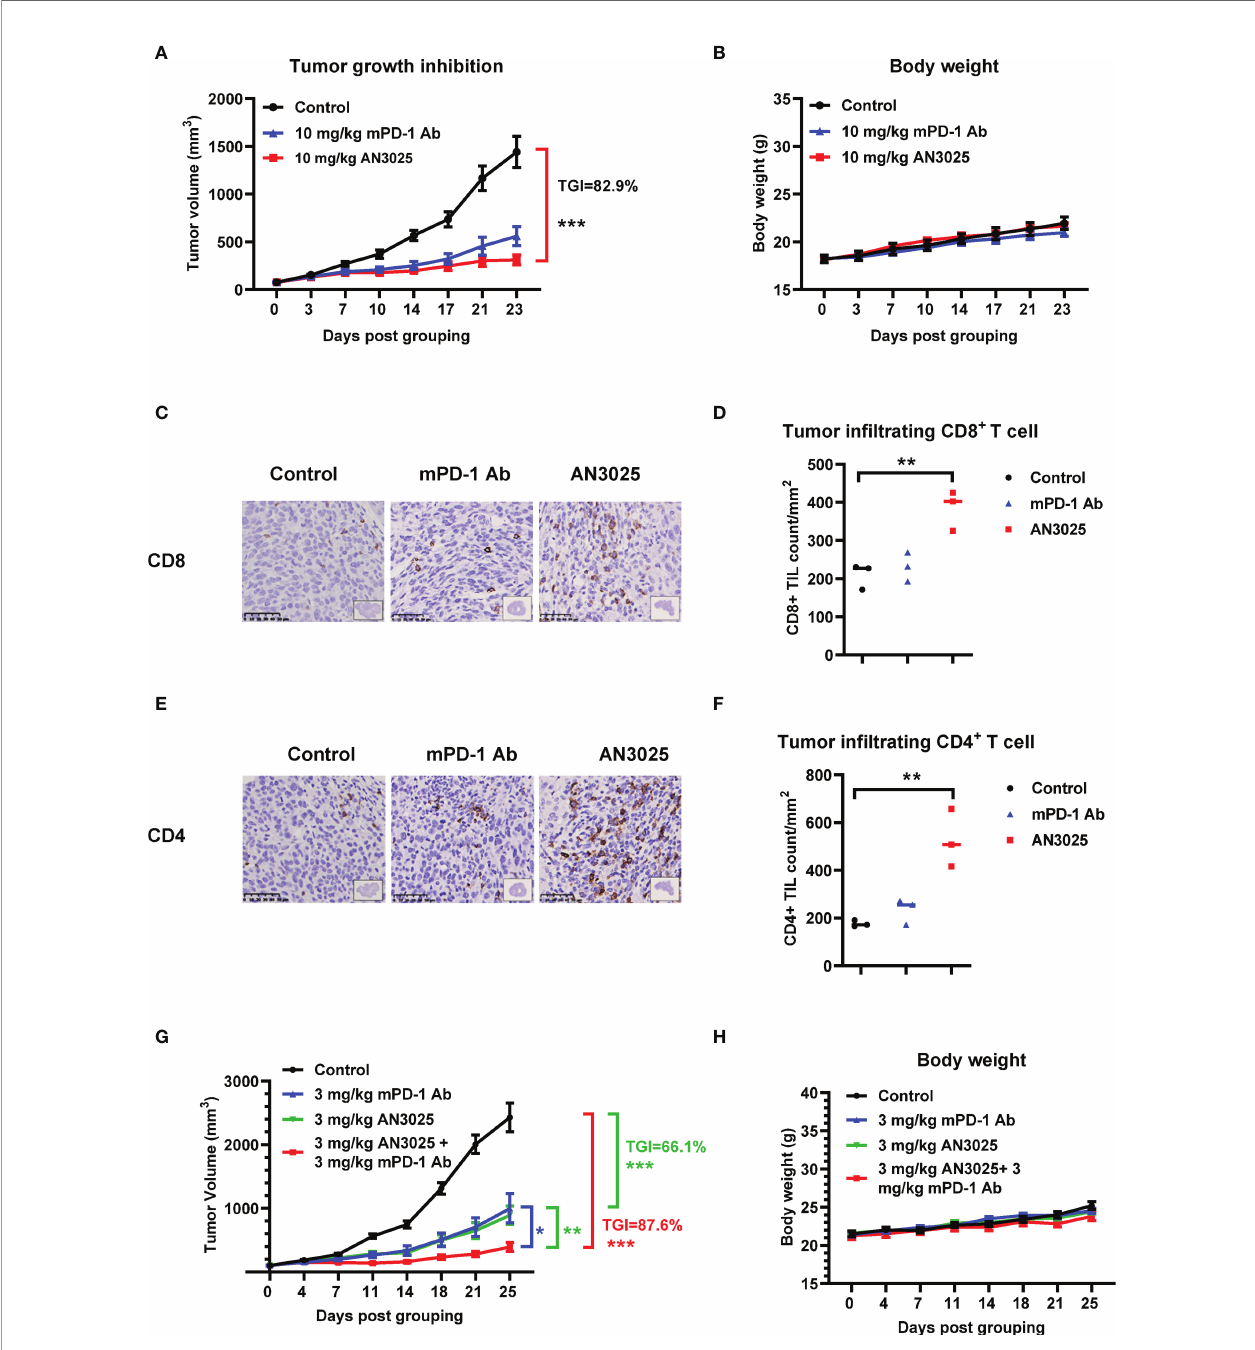
FIGURE 4 | AN3025 enhances anti-tumor ef fi cacy of mouse PD-1 antibody in combination study. (A – H) Murine colon cancer MC38 cells (5E5) were implanted subcutaneously into homozygous TNFR2 humanized mice (female). Mice were grouped when tumor volume reached approximately 100 mm 3 . (A – F) MC38 tumor bearing TNFR2 humanized mice were treated with 10 mg/kg AN3025 or 10mg/kg mouse PD-1 antibody (mPD-1 Ab) every 3 days intraperitoneally for 7 doses in total. (A) Tumor volume measurement during the treatment (n=8 each group). (B) Body weight record during the treatment (n=8 each group). (C) Representative immunohistochemistry images of CD8 staining on MC38 tumors. (D) Quanti fi cations of CD8 + T cells per mm 2 by immunohistochemistry (n=3 each group). (E) Representative immunohistochemistry images of CD4 staining on MC38 tumors. (F) Quanti fi cations of CD4 + T cells per mm 2 by immunohistochemistry (n=3 each group). (G, H) MC38 tumor bearing TNFR2 humanized mice were treated with 3mg/kg AN3025 or 3mg/kg mPD-1 Ab or combination of AN3025 and mPD-1 Ab every 3 days intraperitoneally for 7 doses in total. (G) Tumor volume measurement during the treatment (n=8 each group). (H) Body weight record during the treatment (n=8 each group). Values were expressed as Mean ± SEM. *P < 0.05; **P < 0.01; ***P <